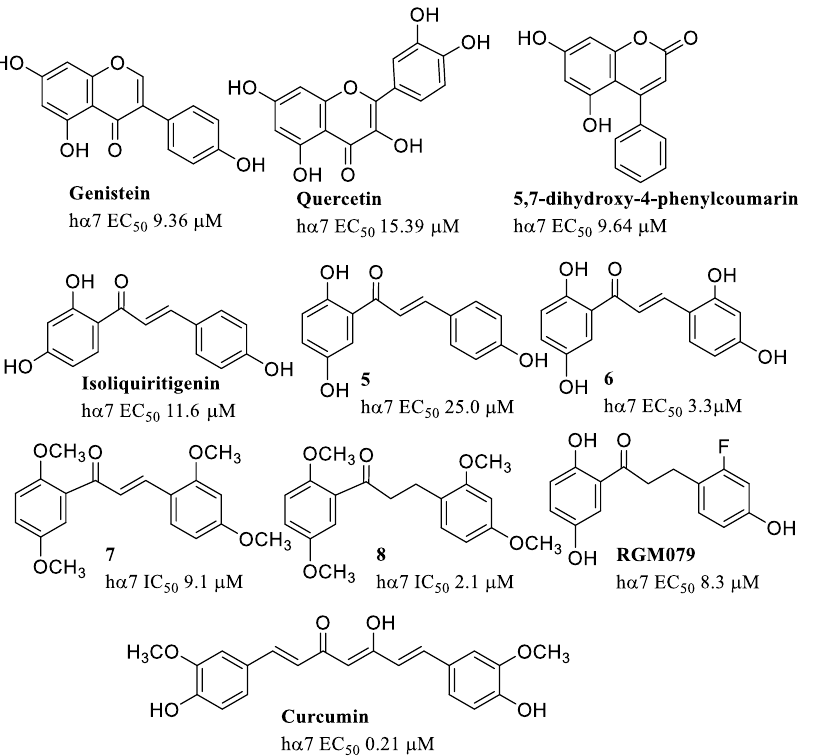
Figure 12. α 7-PAMs from natural sources.